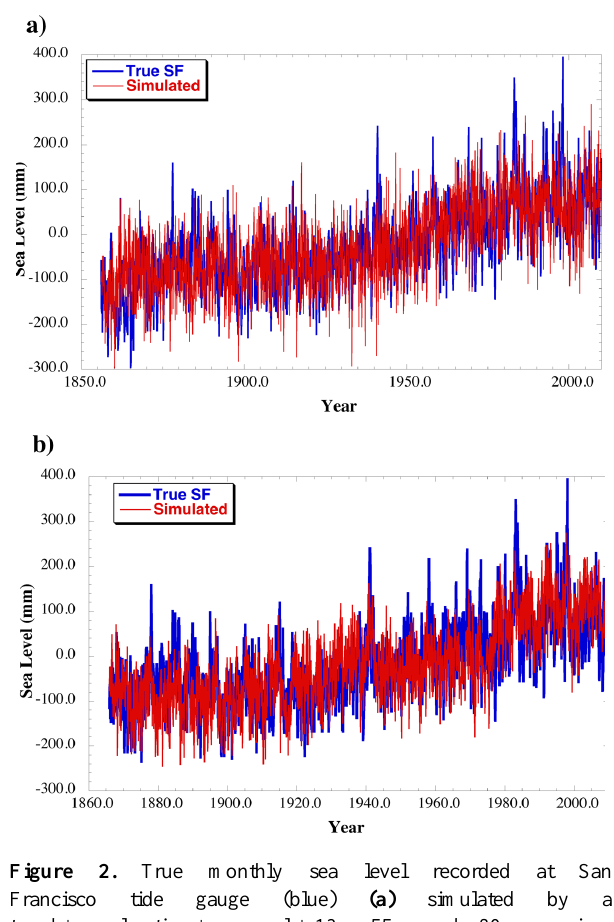
Figure 2. True monthly sea level recorded at San Francisco tide gauge (blue) (a) simulated by a trend + acceleration + seasonal + 13-, 55-, and 80-year sinu- soidal functions with additional random noise (case 1), and (b) simulated by a trend + acceleration + seasonal + ENSO + PDO (case 2). See text for